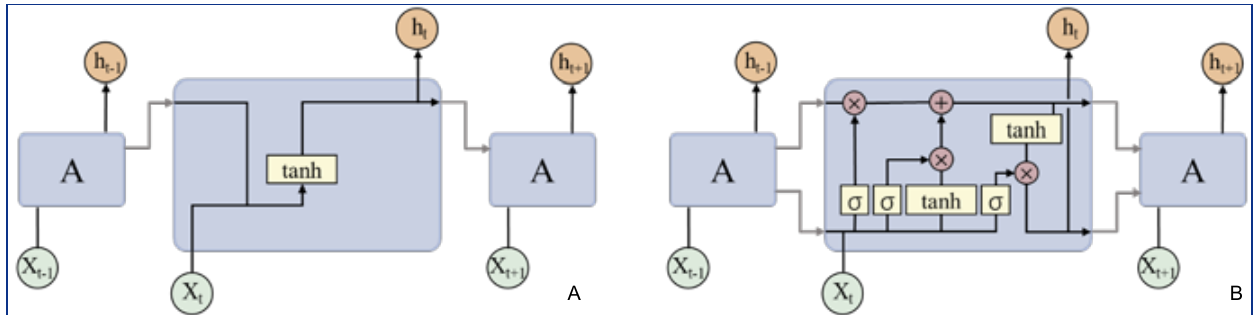
Figure 2 The architecture of RNN. (A) Standard RNN; (B)